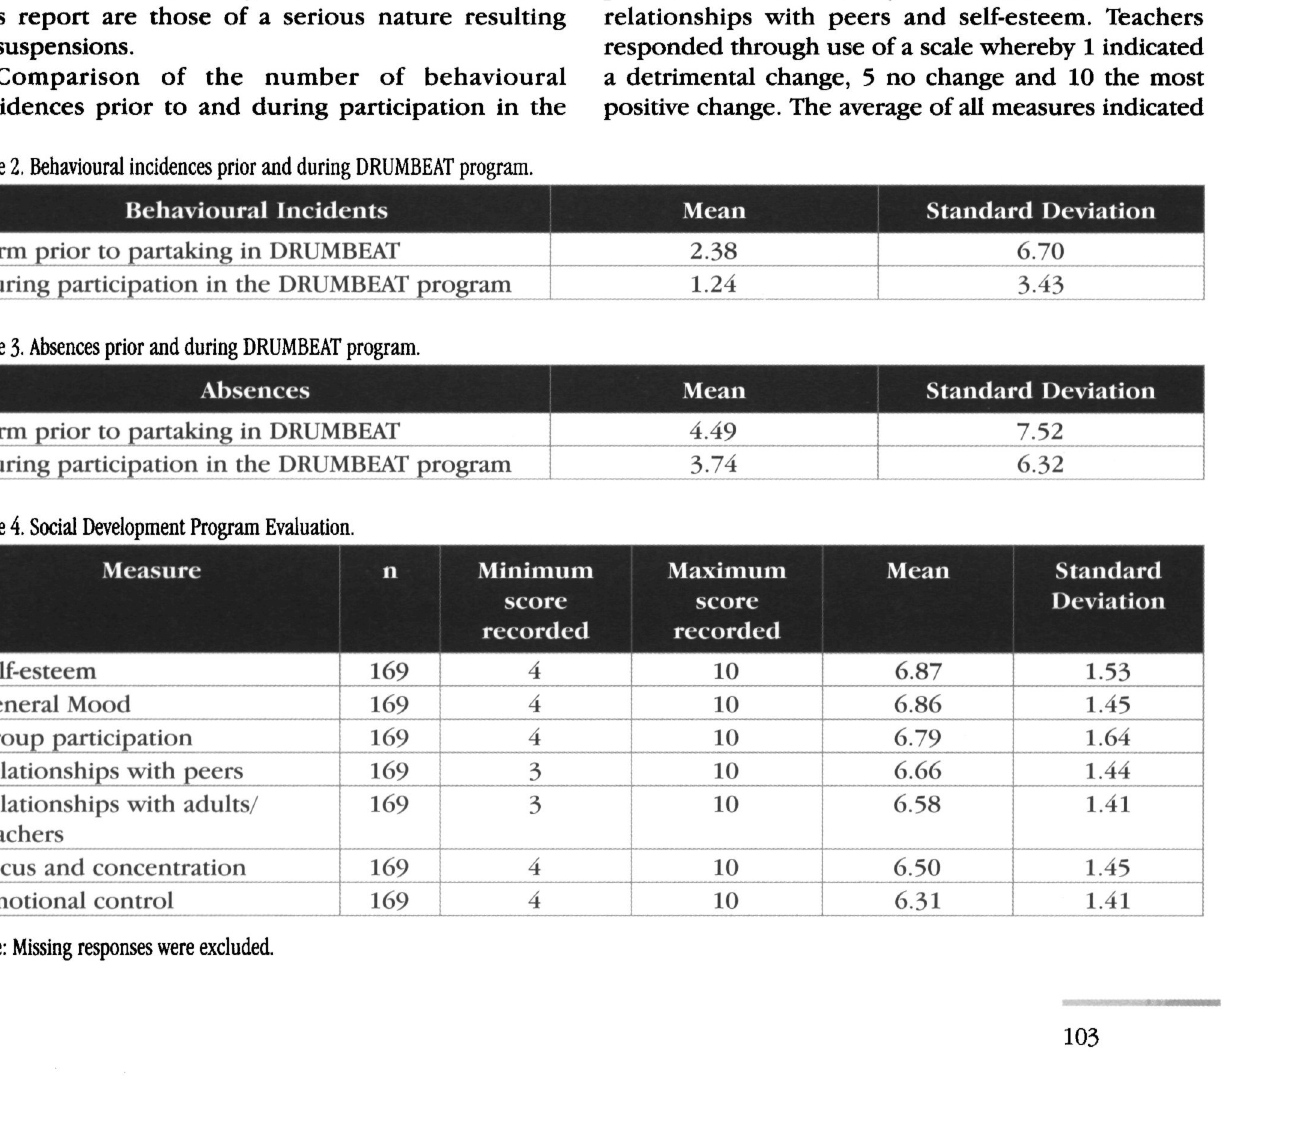
Table 3- Absences prior and during DRUMBEAT program.